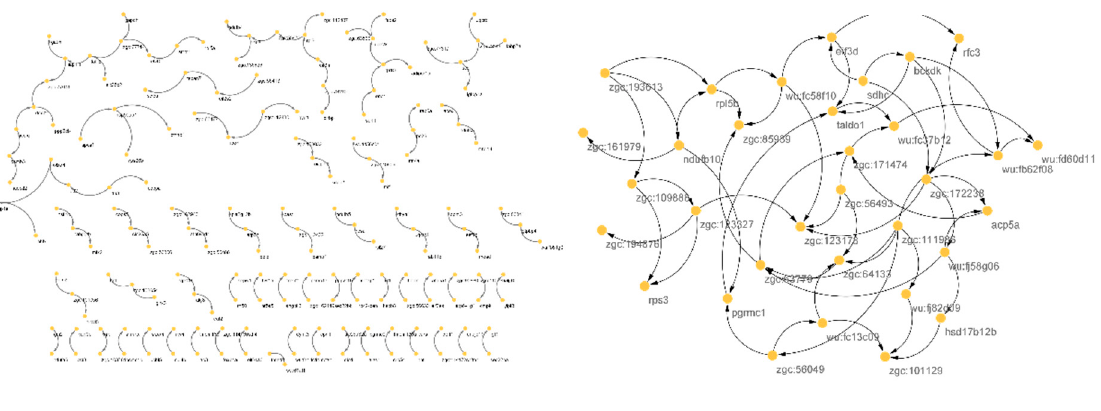
Figure 9. Reconstructed Bayesian network for identified modules (Module 1: left; Module 2: right) of co-expression network. Only connected genes are shown.